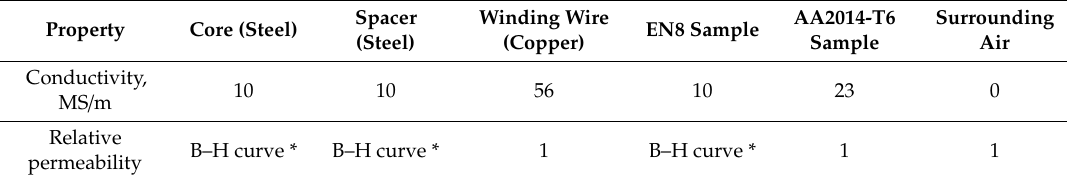
Figure 7. Schematic view of a quartered geometrical model of magnetizer with sample: 1—sample, 2—core; 3—winding (consists of 70 turns), 4—air, 5—spacer. Table 4. Physical properties of components of the